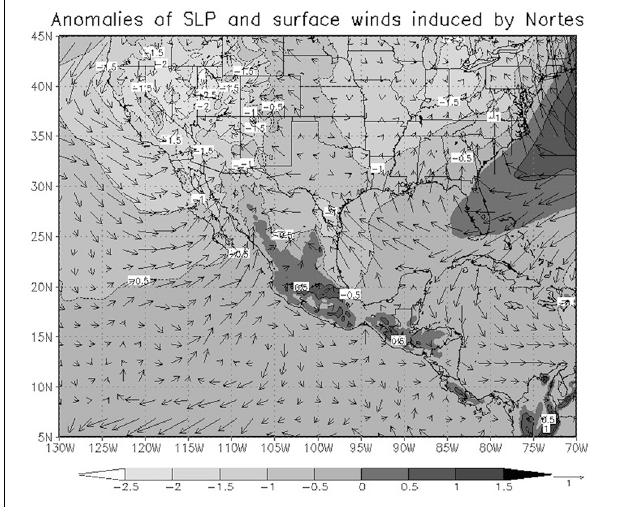
FIGURE 4 | Changes in sea level pressure (hPa) and surface winds (m/s) for winter 2080–2089 relative to 1980–1989, during the cold surge conditions during the impact of intense winds over Veracruz (based on composite patterns of Figure